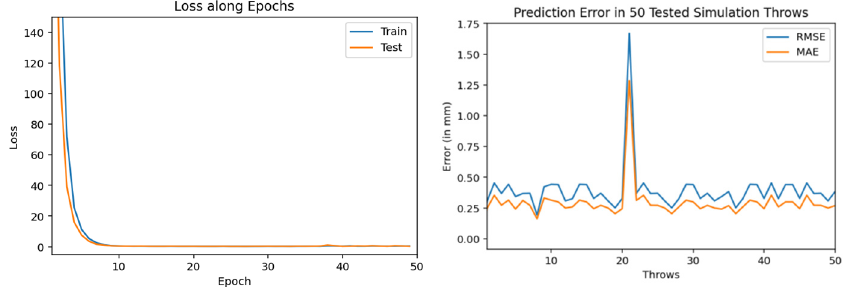
Figure 12. Training and testing results by encoder-decoder bidirectional LSTM deep NN. ( trained through 1000 throws with 200 epochs and 100 neurons) .